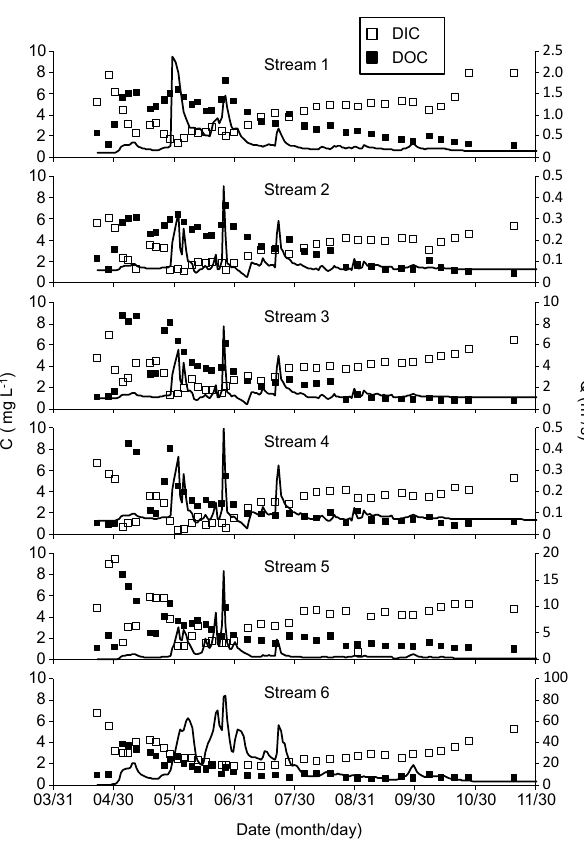
Fig. 2. Annual variation (2008) in stream water DOC and DIC con- centrations in the six streams studied. The black line shows stream water flow.